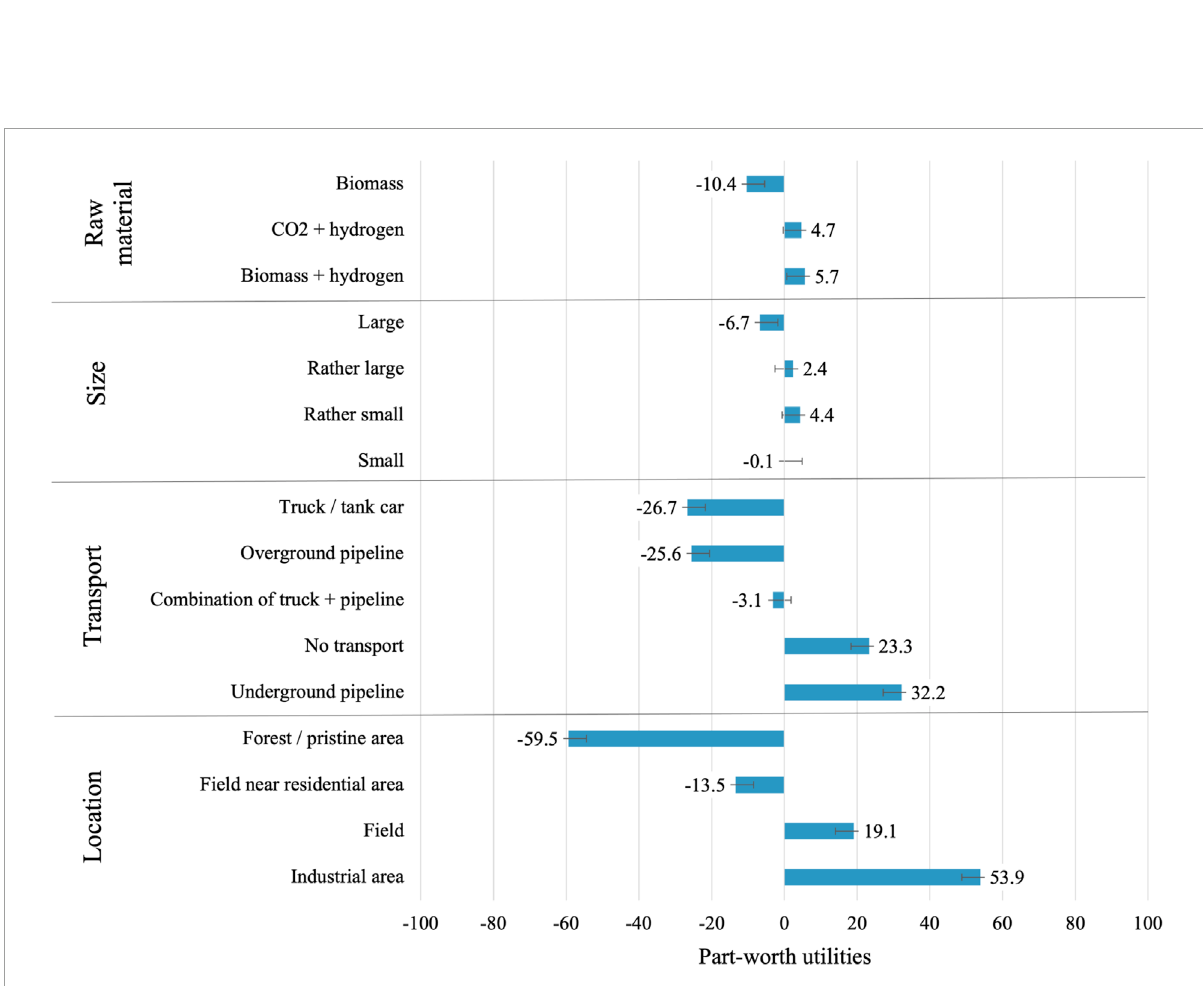
FIGURE 5 Part-worth utilities (zero-centered diffs) for the attribute levels ( n = 303). Error bars indicate standard